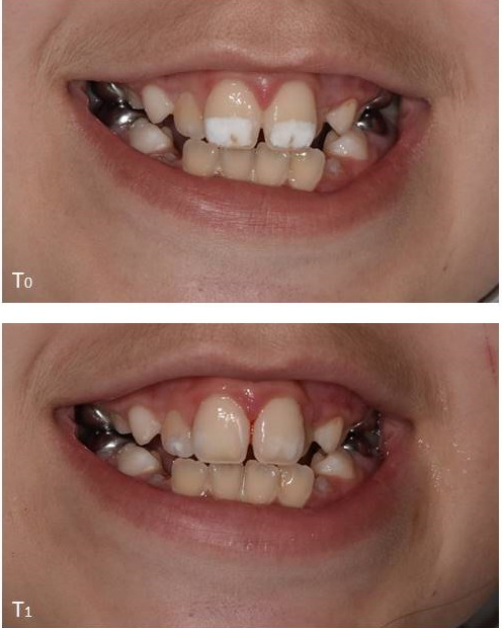
Figure 1. Clinical images to show the appearance of a ‘typical’ participant’s permanent central maxillary incisors before (T 0 ) and one-month after (T 1 ) treatment (microabrasion followed by resin